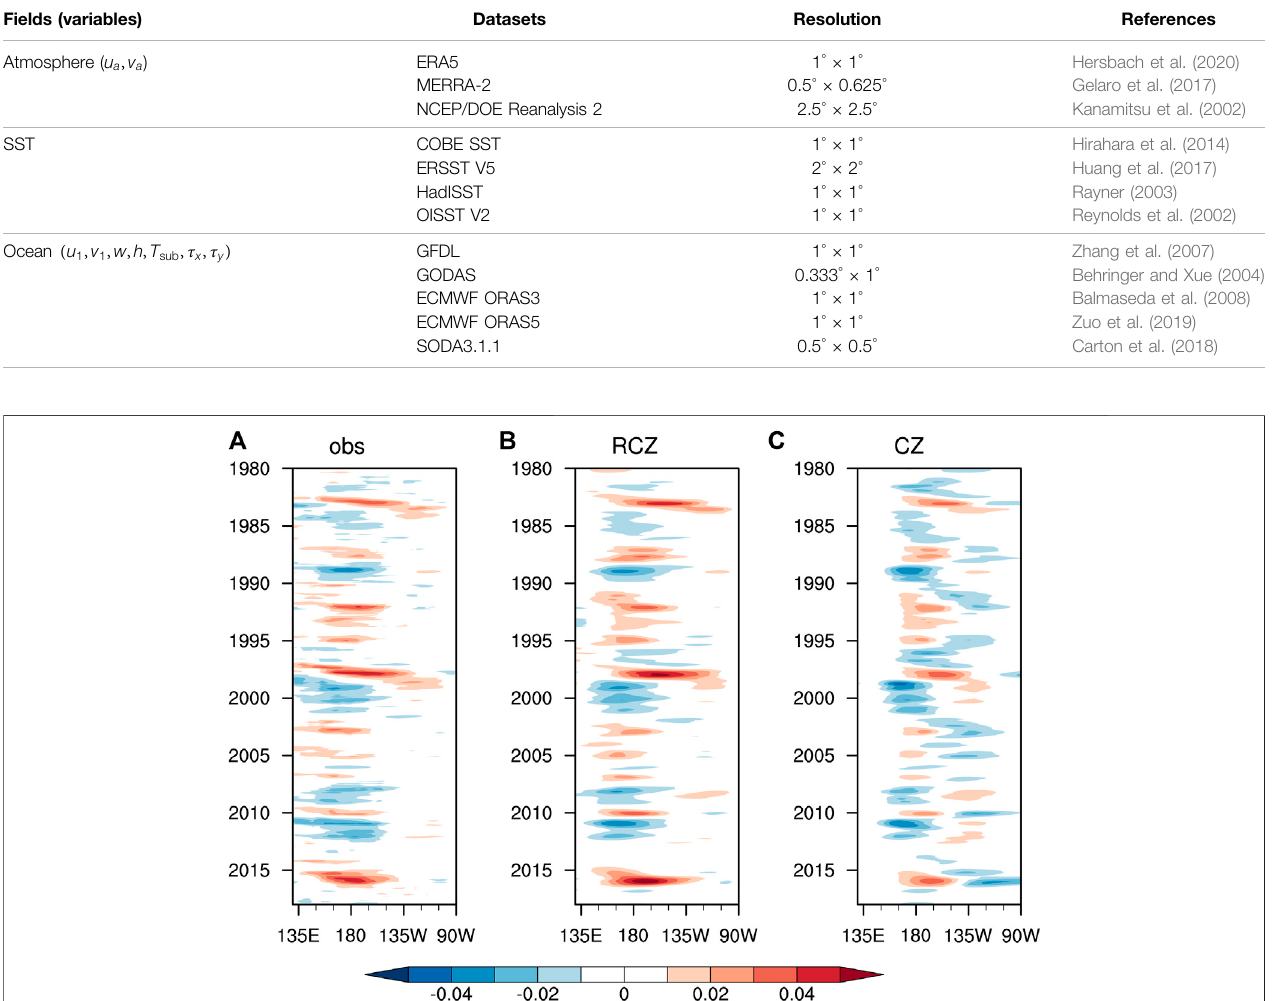
FIGURE 4| Time evolution of (A) the observed, (B) the RCZ-simulated, and (C) the CZ model-simulated equatorial (5 ° S – 5 ° Naverage) zonal wind stress anomalies (unit: N/m 2 ) during 1980 – 2018. The model simulations are performed with the atmospheric component only and are driven by the observed SSTA.